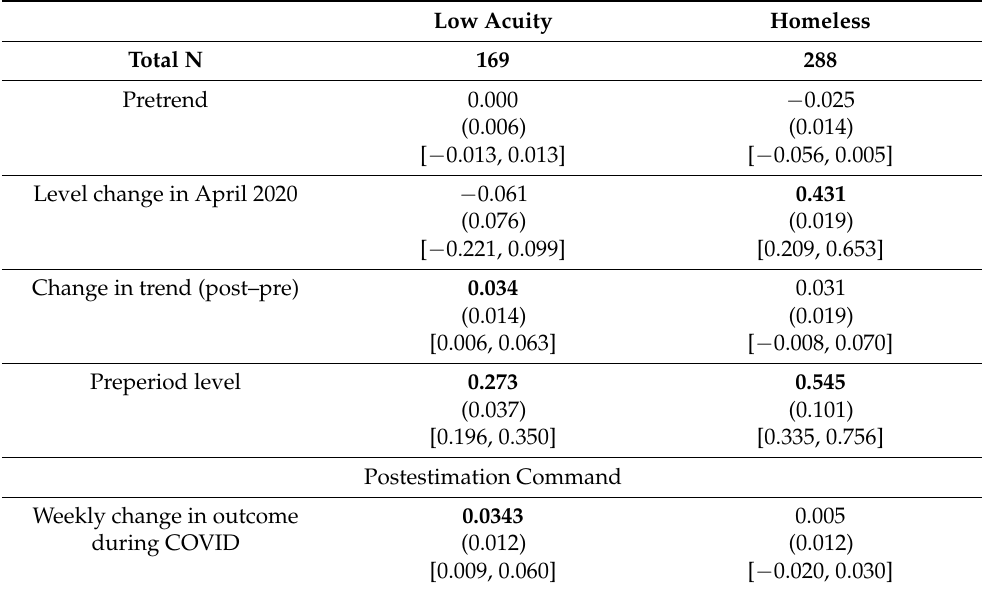
Table A3. OUD-Related ED Visit Characteristics by Race/Ethnicity: White Patients.